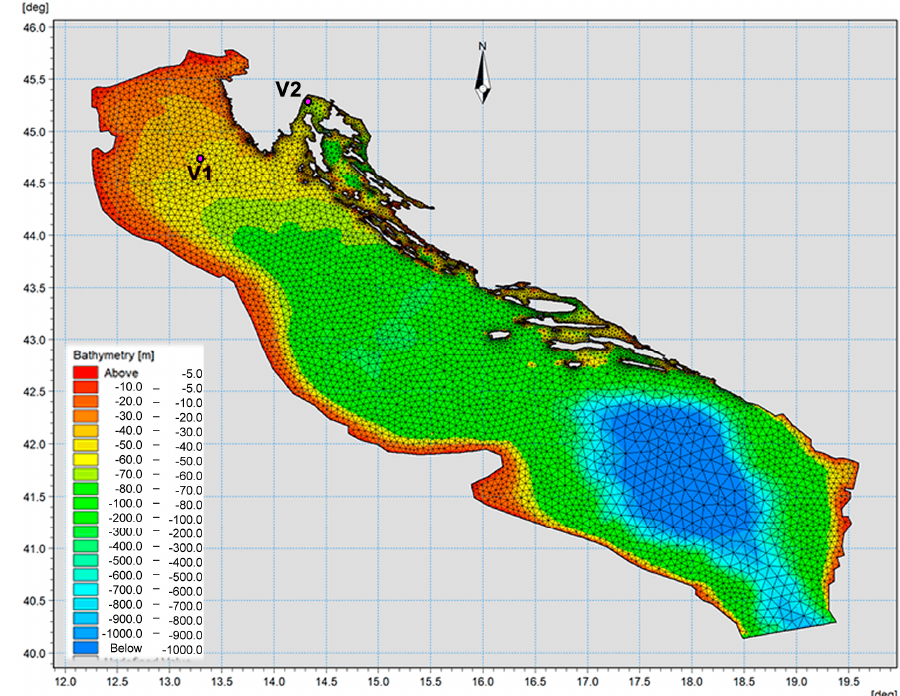
Figure 16. Model domain spatial discretization with unstructured finite volume grid on bathymetric background and locations of wave rider stations V1 ( ϕ = 44°44.57 ′ N, λ = 13°17.98 ′ E) and V2 ( ϕ = 45°19.37 ′ N, λ = 14°18.7 ′ E).